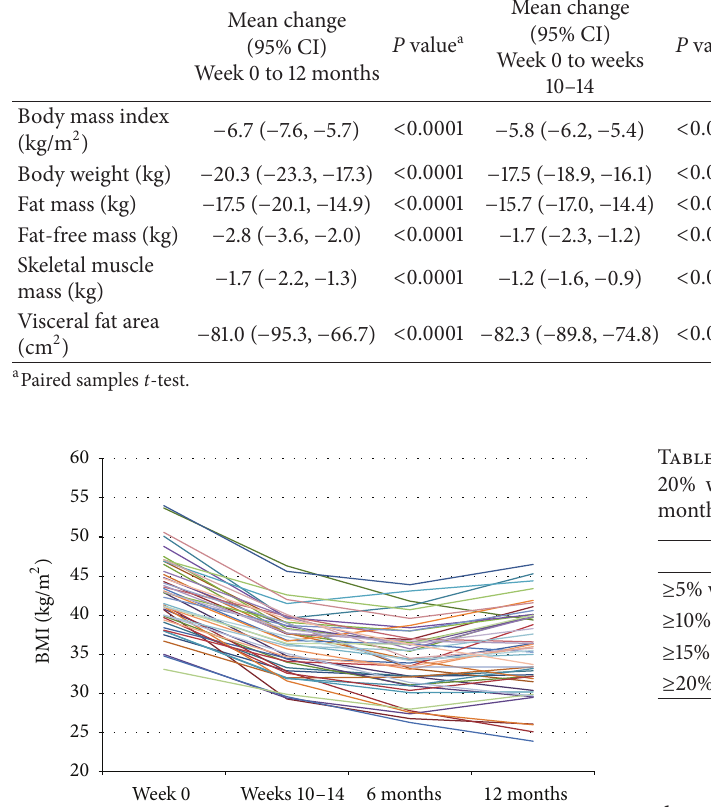
Figure 4: BMI value for each subject within the ILI-group at week 0, week, 10–14, six, and 12 months. Note: two subjects had a BMI < 35 kg/m 2 at week 0 due to a small weight reduction between the time of referring and the start of the treatment program.